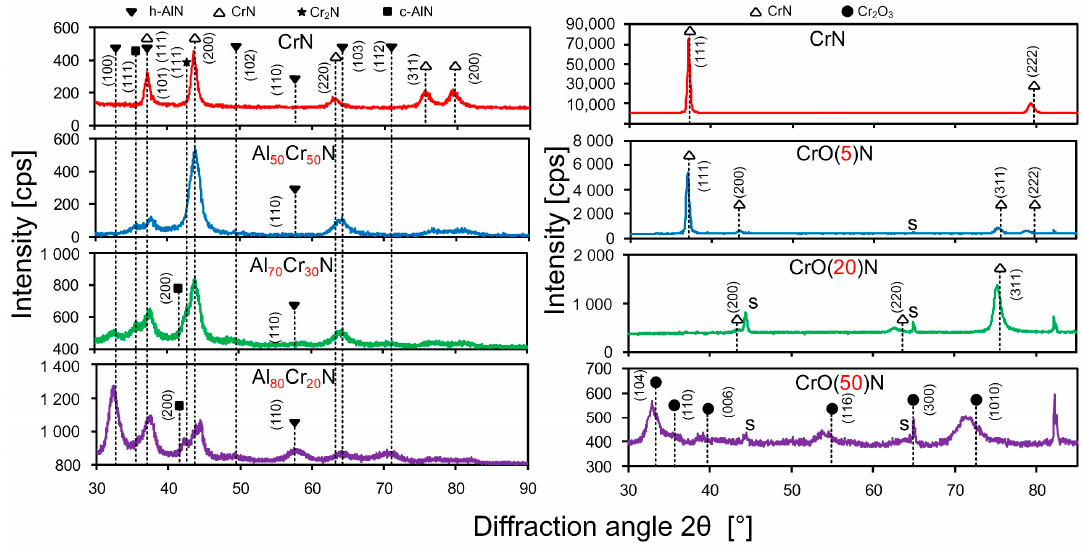
ff raction (XRD) di ff raction patterns of AlCrN and CrON Figure 1. X-ray diffraction (XRD) diffraction patterns of AlCrN and CrON coatings. Figure 1. X-ray di